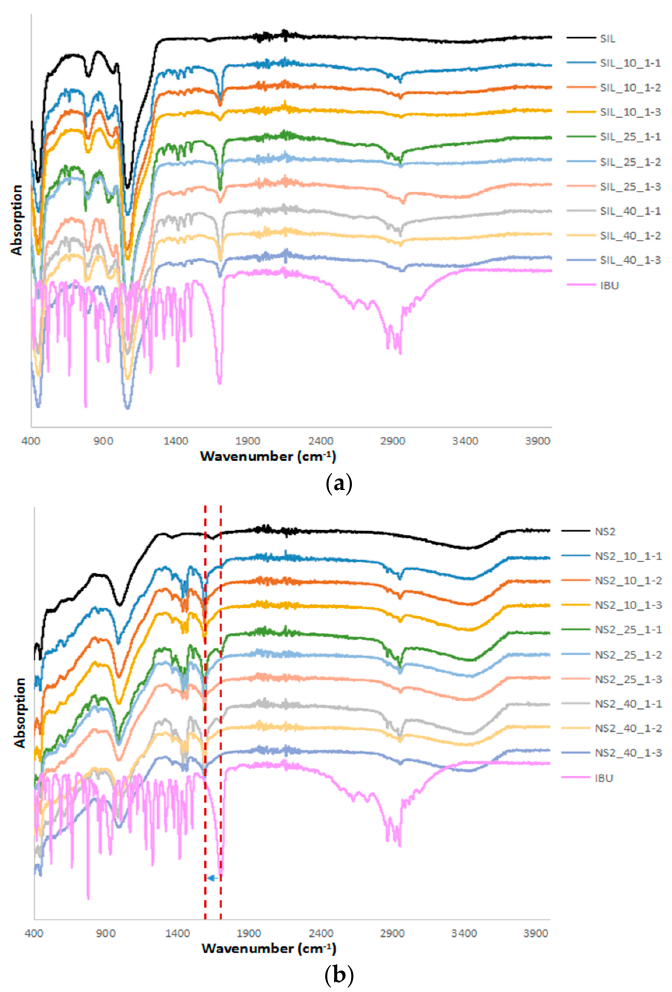
Figure 2. Fourier transform infrared (FTIR) results of drug-loaded ( a ) S244FP and ( b ) NS2 under different drug loading conditions (refer to Table 1 for sample details).